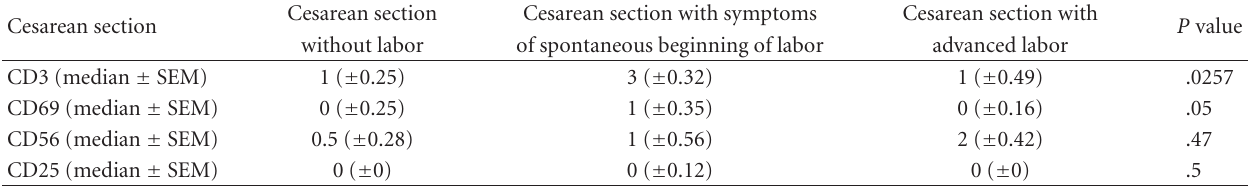
Table 3: The immunoreactivity of CD3, CD56, CD69, CD25 antigens within decidua during the cesarean section.